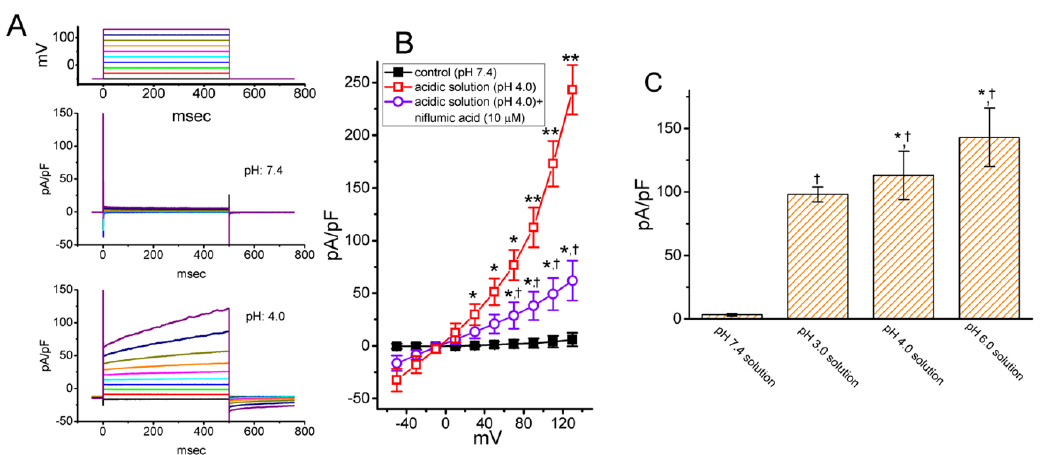
Figure 4. Biophysical and pharmacological properties of the proton-induced Cl − current ( I PAC ) density identified in GH 3 cells. The experiments were undertaken in cells which were kept bathed in Ca 2+ -free Tyrode’s solution, and the recording electrode was filled up with Cs + -containing solution. ( A ) Representative I PAC densities obtained in cells exposed to the control condition (i.e., pH 7.4, upper) or to the acidic solution (i.e., pH 4.0, lower). The voltage protocol delivered is illustrated in the uppermost part. ( B ) Mean current density versus voltage relationships of I PAC (mean ± SEM; n = 8